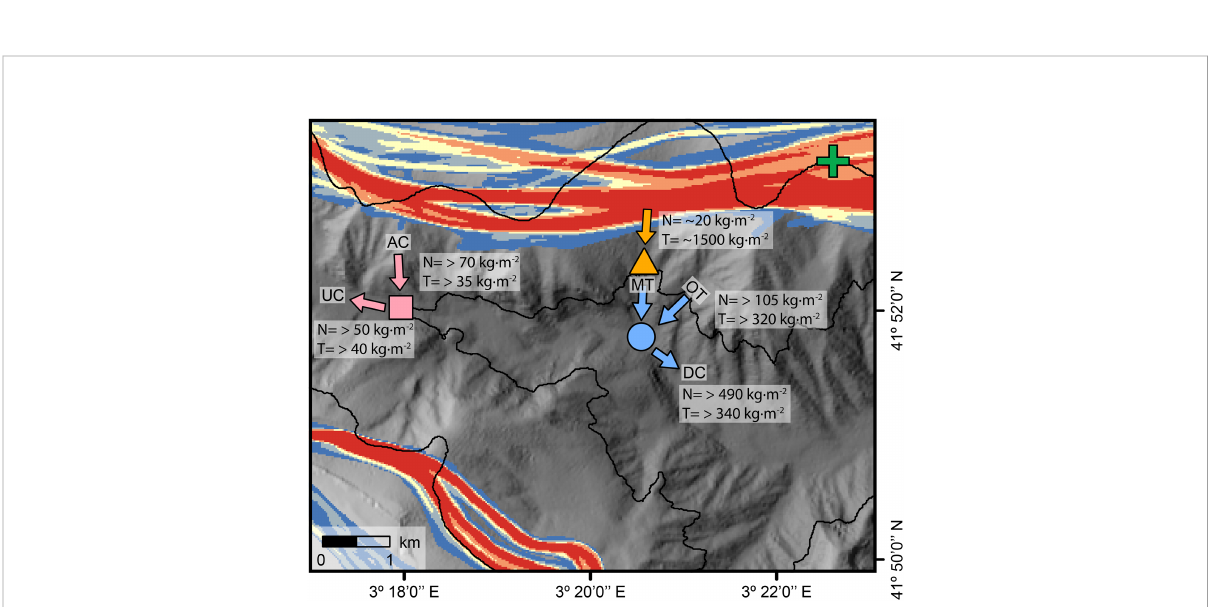
FIGURE 10 Map of main sediment transport pathways of the three mooring locations in Palamo ́ s Canyon: up-canyon (UC) and across-canyon (AC) for Axis- 900 mooring (pink square), Montgr ı ́ tributary gully (MT) for Flank-900 mooring (orange triangle), other tributary gully (OT), and down-canyon (DC) for Axis-1200 mooring (blue circle). Annotated in the fi gure is the cumulative sediment transport for natural high-energy events (N) and trawling-derived events (T). Note that the across-canyon cumulative transport for the Axis-1200 mooring combines sediment transported through both tributaries (MT and